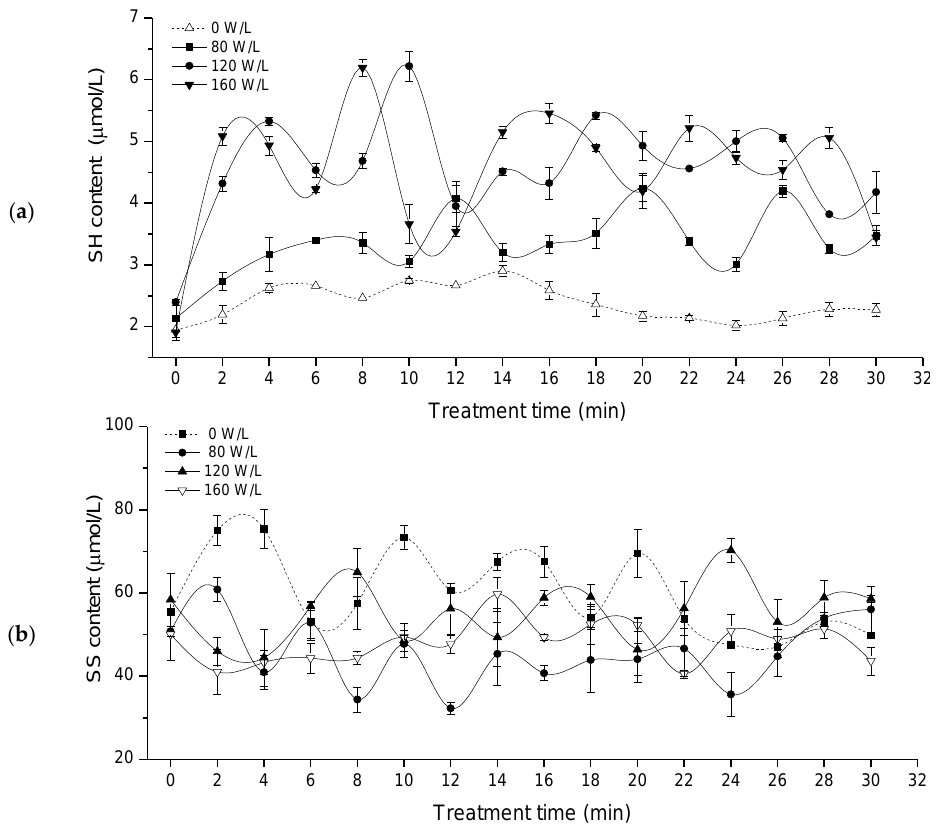
Figure 1. The changes of SH and SS contents during ultrasound pretreatment process. ( a ) SH content; ( b ) SS content.